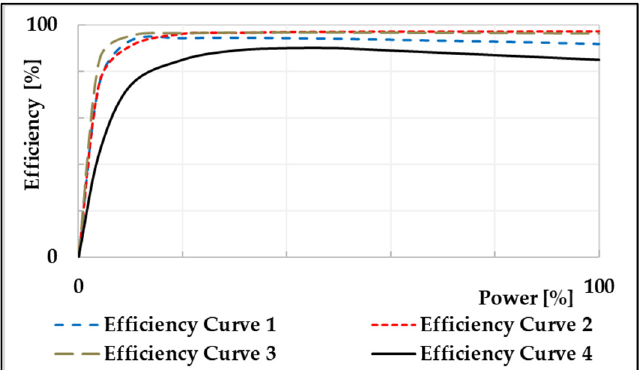
Figure 2. Typical Efficiency curves from [19–22] .